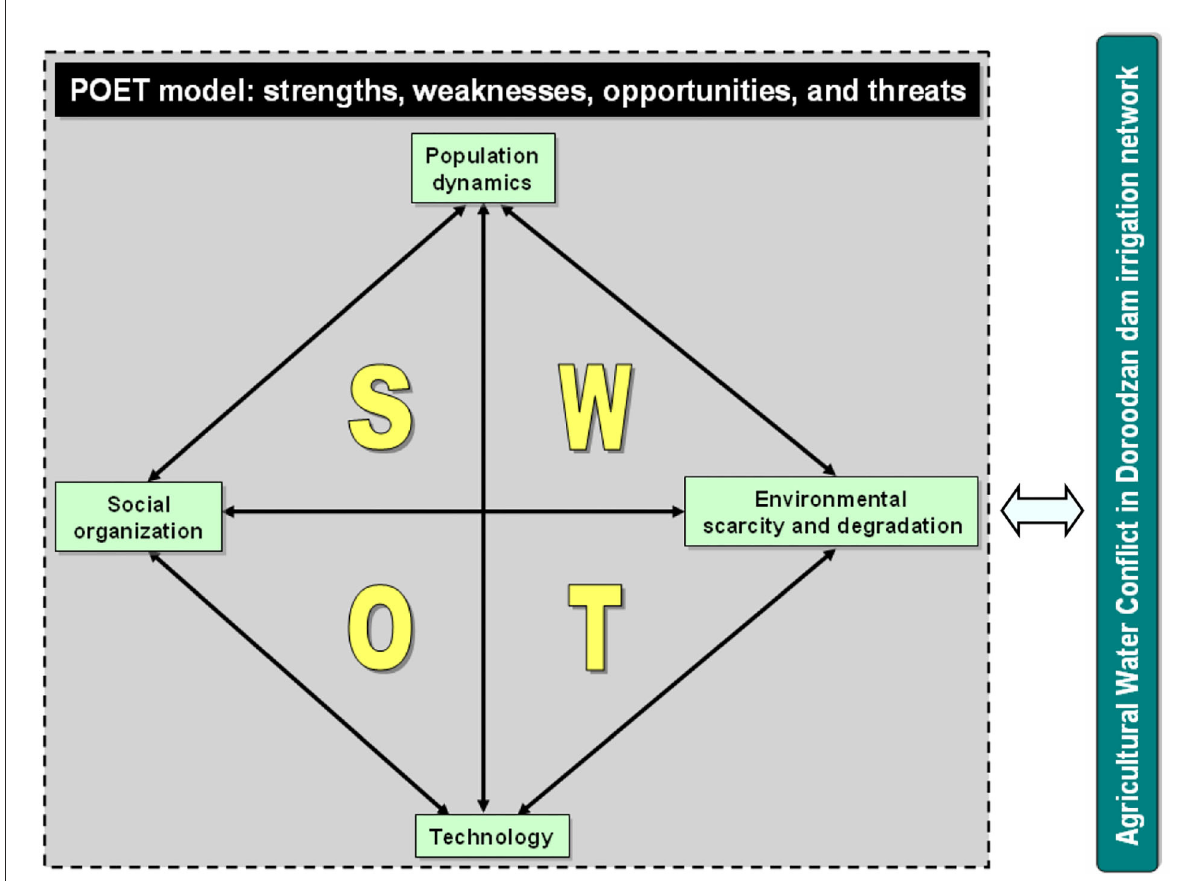
FIGURE1 Theoretical faramework to investigate water conflict in a human ecological perspective.